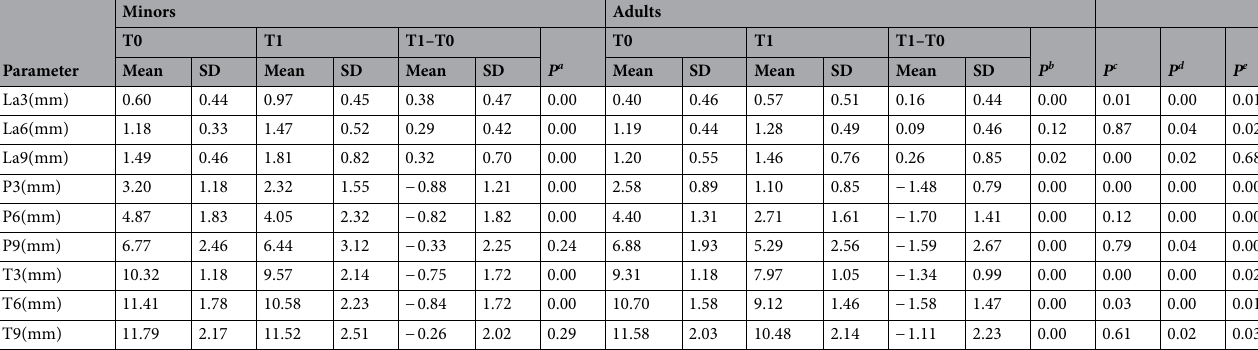
Table 2. Changes of the alveolar bone thickness at the crestal, mid-root and apical third in the central incisor. SD standard deviation, T0 before orthodontic treatment, T1 after orthodontic treatment, T1–T0 difference value during T0 to T1. a Represents the P-value of t test of T1–T0 in the minors group. b Represents the P-value of t test of T1–T0 in the adults group. c Represents the P-value of t test of T0 between the two groups. d Represents the P-value of t test of T1 between the two groups. e Represents the P-value of t test of T1–T0 between the two groups.